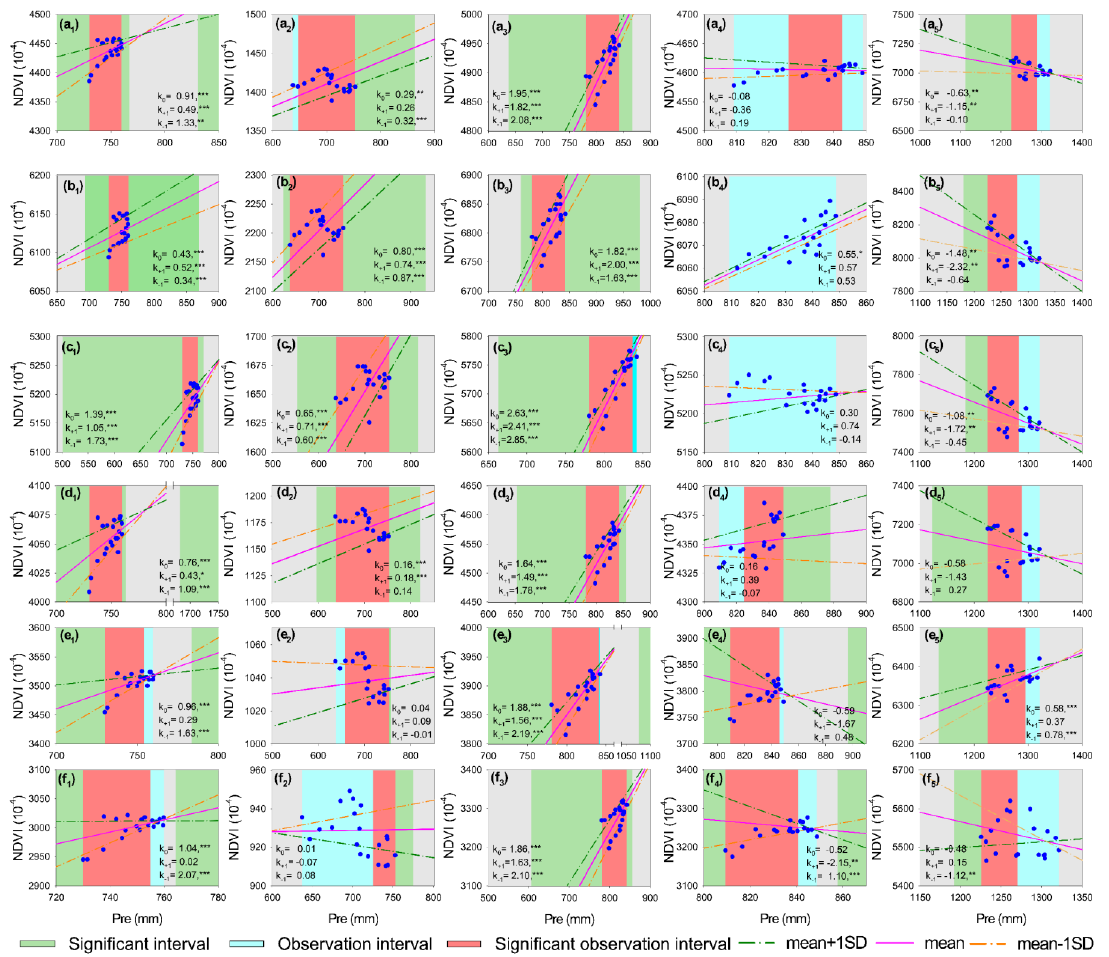
Figure 3. The regulatory effect of temperature on the relationship between precipitation and NDVI. Mean and mean ± 1SD denote the regression equations established between precipitation and NDVI when the temperature was set to the mean and mean ± 1SD, respectively, and the corresponding simple slopes are k 0 and k ± 1 . Significant interval indicates the precipitation at which the temperature presented a significant moderating effect, according to the J–N analysis range. The observation interval represents the actual observation interval of precipitation. Significant observation interval indicates the actual precipitation range for which the temperature presented a significant regulating effect. Note: ( a – f ) refer to Mean, P 100 , P 75 , P 50 , P 25 , and P 5 , respectively, while ( 1 – 5 ) refers to the SW, T + * –P + * , T + * –P – , T + * –P + , and NSC areas, respectively. * p < 0.05, ** p < 0.01, *** p <